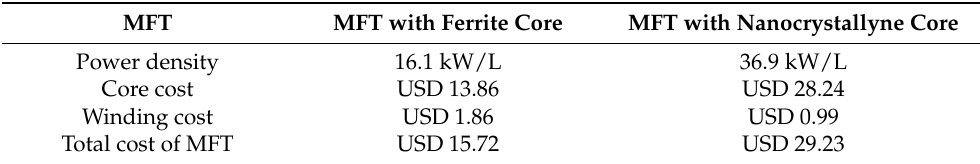
Table 11. Efficiencies obtained at 50%, 25%, and 6% of the nominal power.